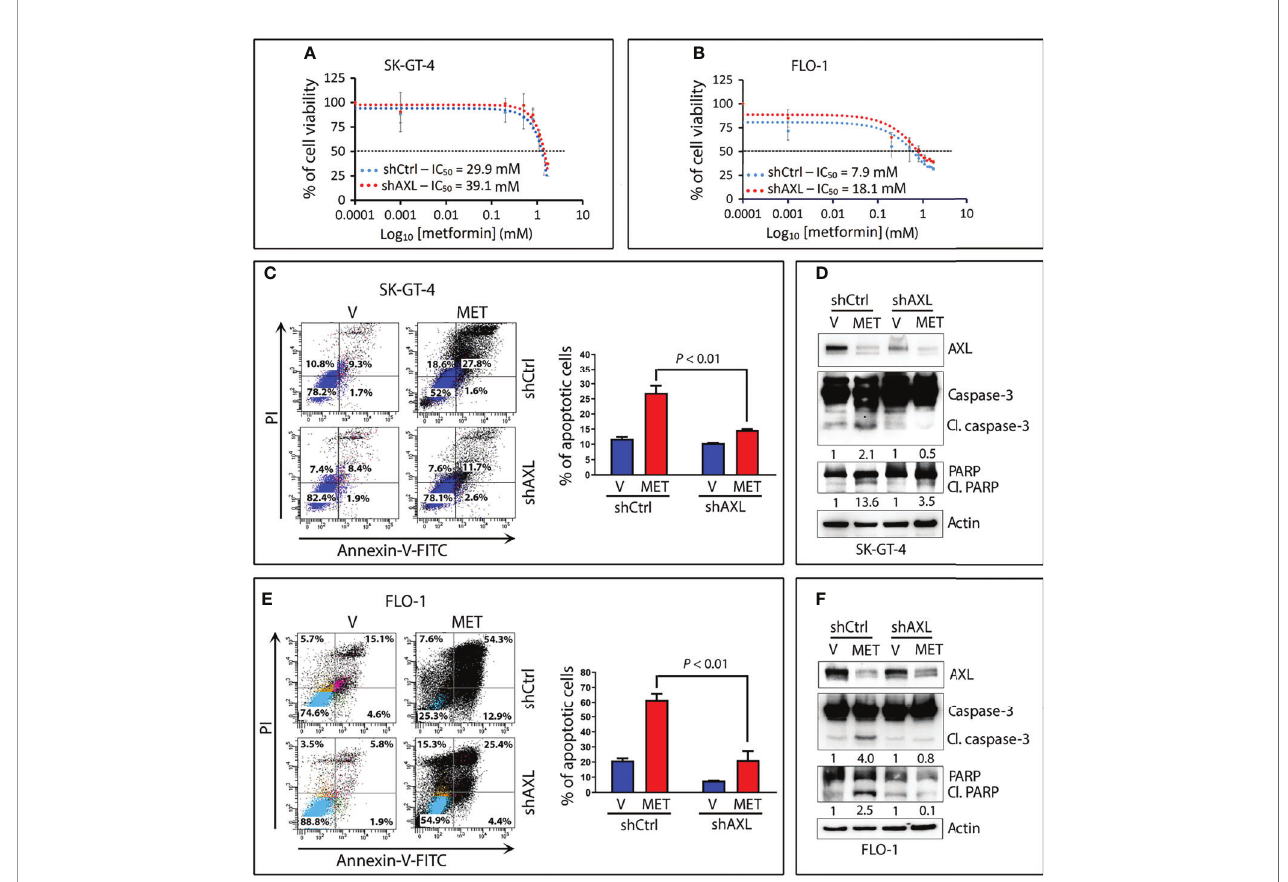
FIGURE 6 | Downregulation of AXL expression attenuates metformin-induced apoptotic cell death in EAC cells. SK-GT-4-shCtrl and SK-GT-4-shAXL cells (A) or FLO-1- shCtrl and FLO-1-shAXL cells (B) were subjected to CCK-8 cell viability assay following treatment with the indicated metformin concentrations for 72 h. (C) SK-GT-4- shCtrl and SK-GT-4-shAXL cells were treated with vehicle or metformin (15 mM) for 96 h. Apoptosis was determined by Annexin-V/FITC staining and FACS analysis. (D) Immunoblot analysis of AXL, caspase-3, and PARP proteins in cell lysates from SK-GT-4-shCtrl and SK-GT-4-shAXL cells treated with vehicle or 15 mM metformin for 96 h. (E) Apoptosis in FLO-1-shCtrl and FLO-1-shAXL cells after treatment with vehicle or 10 mM metformin for 72 h was assessed as in panel (C) . (F) Western blot analysis of AXL, caspase-3, and PARP proteins in FLO-1-shCtrl and FLO-1-shAXL cells treated with vehicle or 10 mM metformin for 72 h. Gel loading was normalized for equal b -actin. Data are representative of three independent experiments and statistical analysis was evaluated by one-way ANOVA followed by the Newman-Keuls post hoc